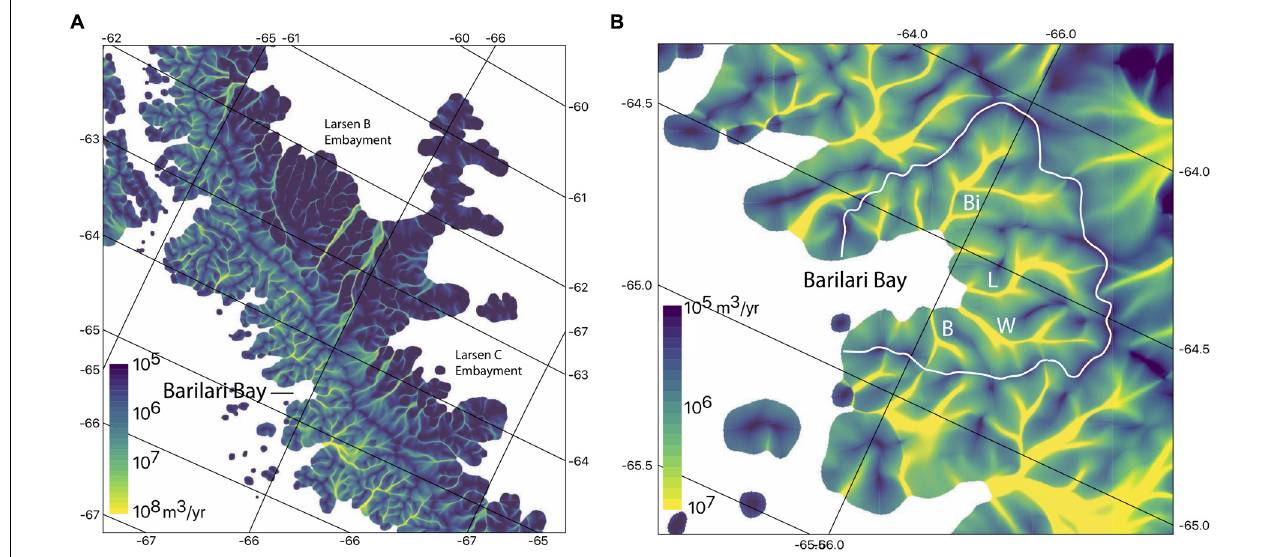
FIGURE 2 | Estimated flux of ice from glacier catchments in Barilari Bay. Flux in each grid cell is calculated as a mean over the 100 m grid size. The coastline is based on the MOA 2009. (A) The flux over a wider region that includes both sides of the peninsula and shows the location of Barilari Bay to the Larsen B and C embayments. (B) Barilari Bay identifying the same four glaciers as in Figure 1C . White line delineates the ice divides separating drainage